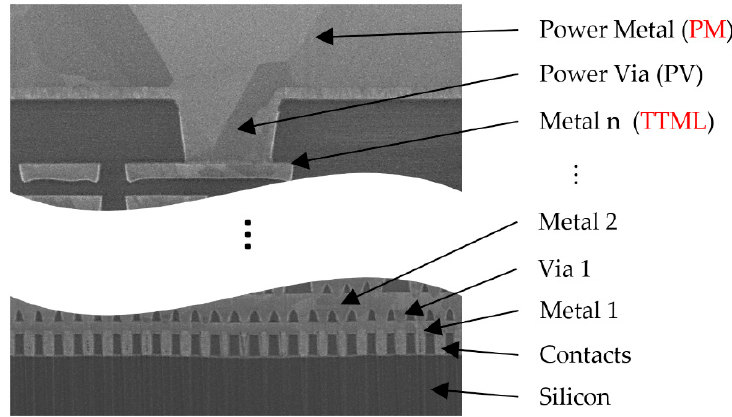
Figure 1. Cross-section through a typical metal stack of a smart power IC.